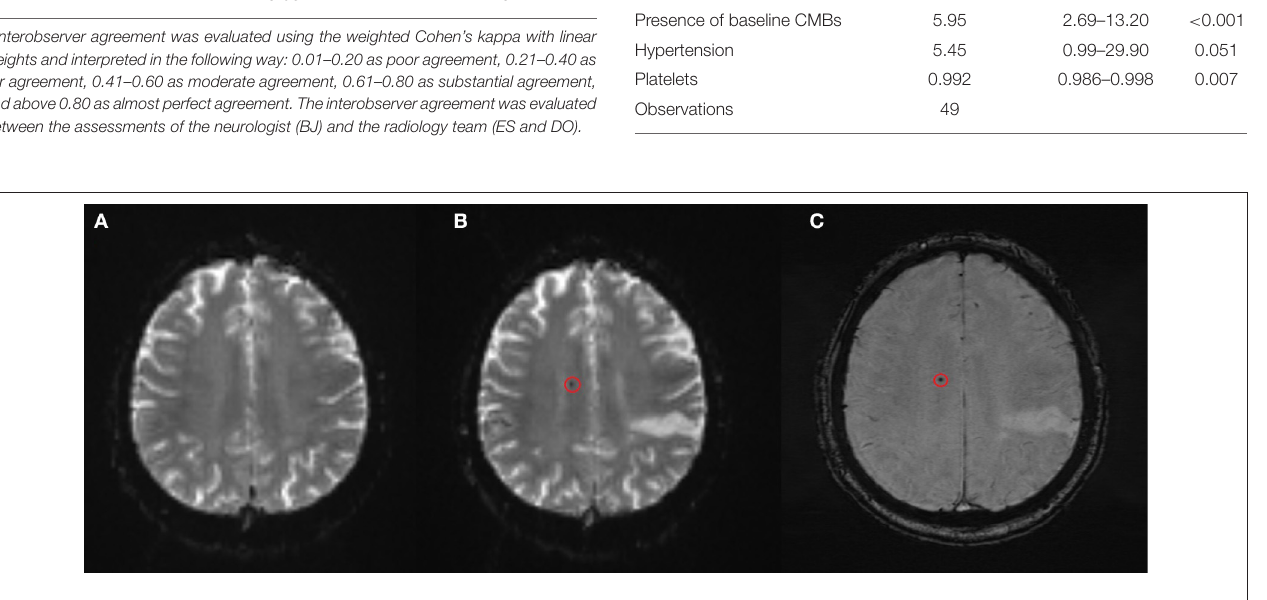
Frontiers in Neurology |